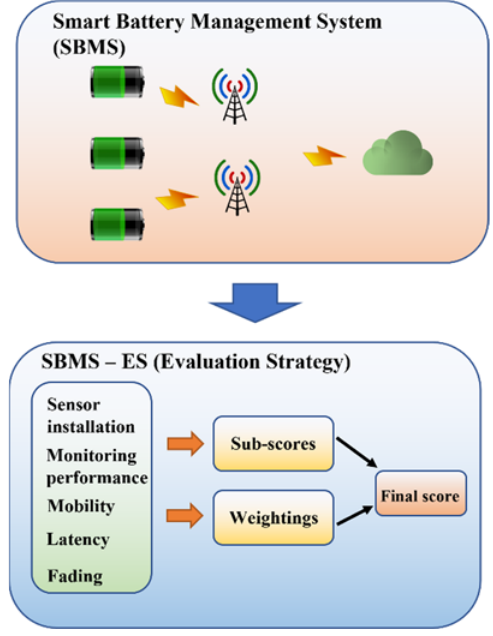
Figure 1. Flowchart of SMBS-ES.